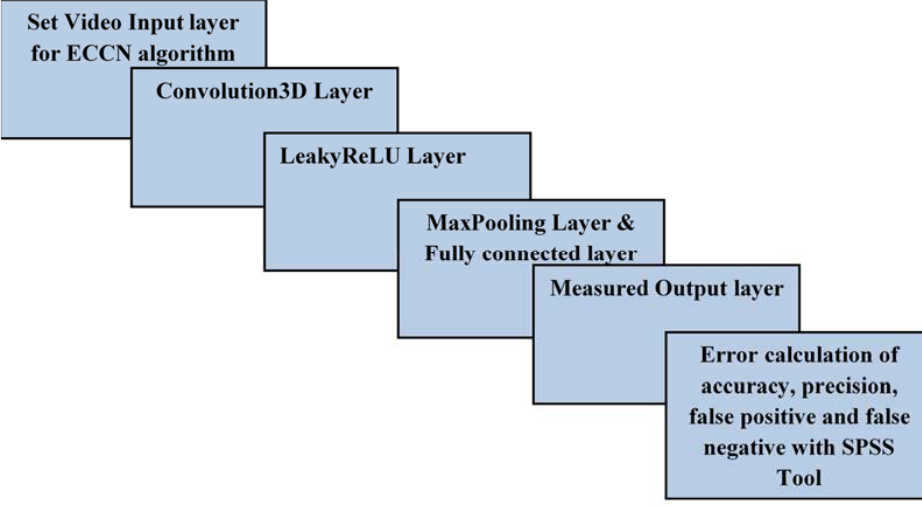
Figure 3. ECNN algorithm’s layered working mechanism with video data input and